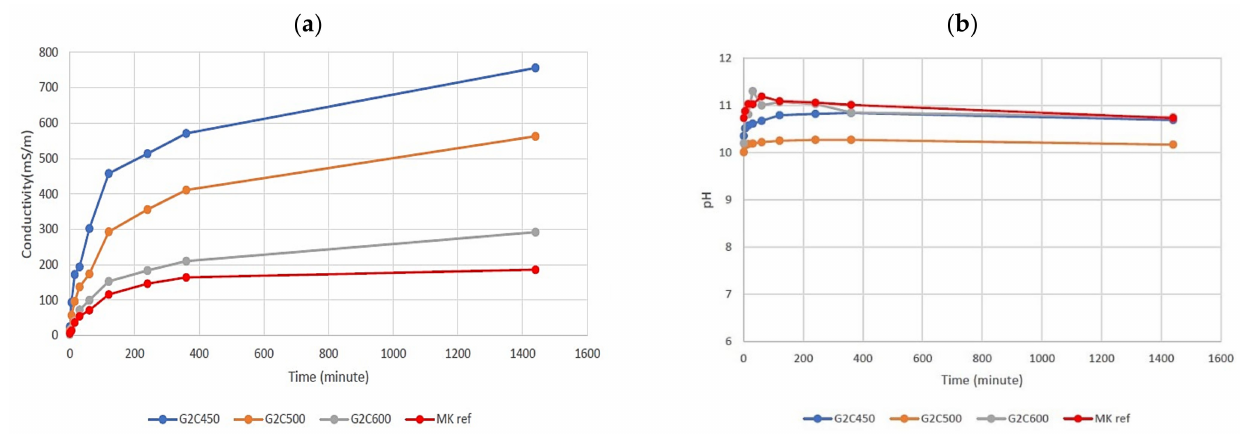
Figure 5. Results of ionic conductivity ( a ) and pH ( b ), respectively, for eluates from samples G2C600, G2C500, and G2C450. Geopolymers produced with commercial metakaolin were used as reference materials data from Ref.